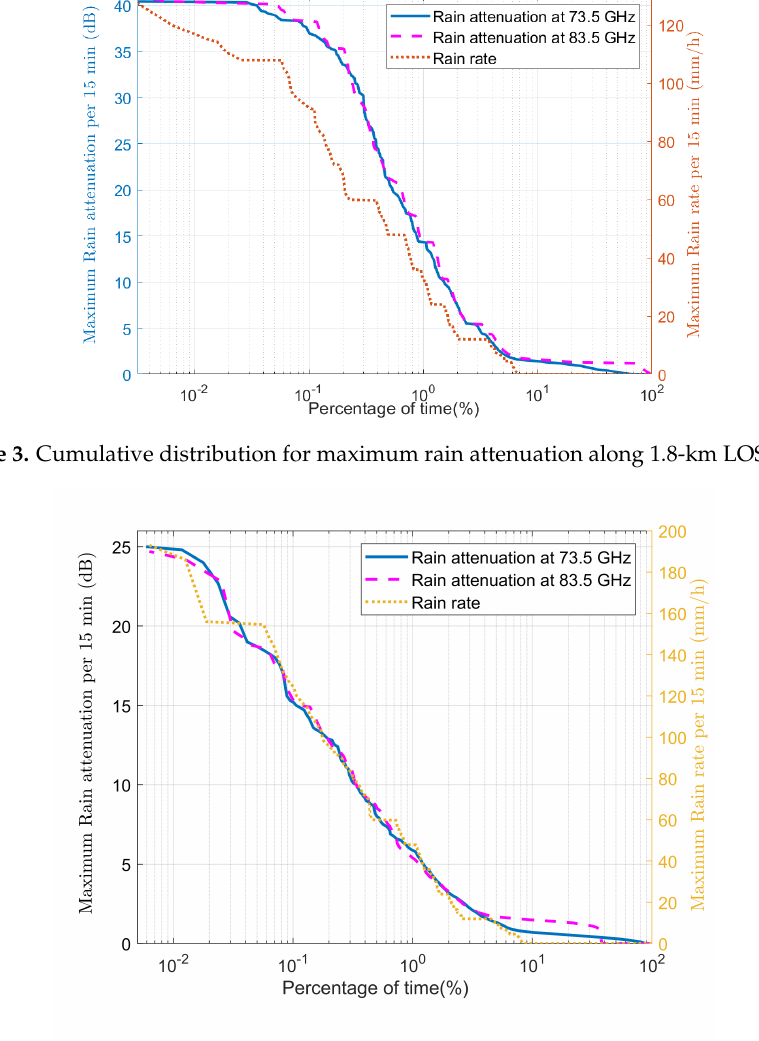
Figure 4. Cumulative distribution for maximum rain attenuation along 300-m LOS